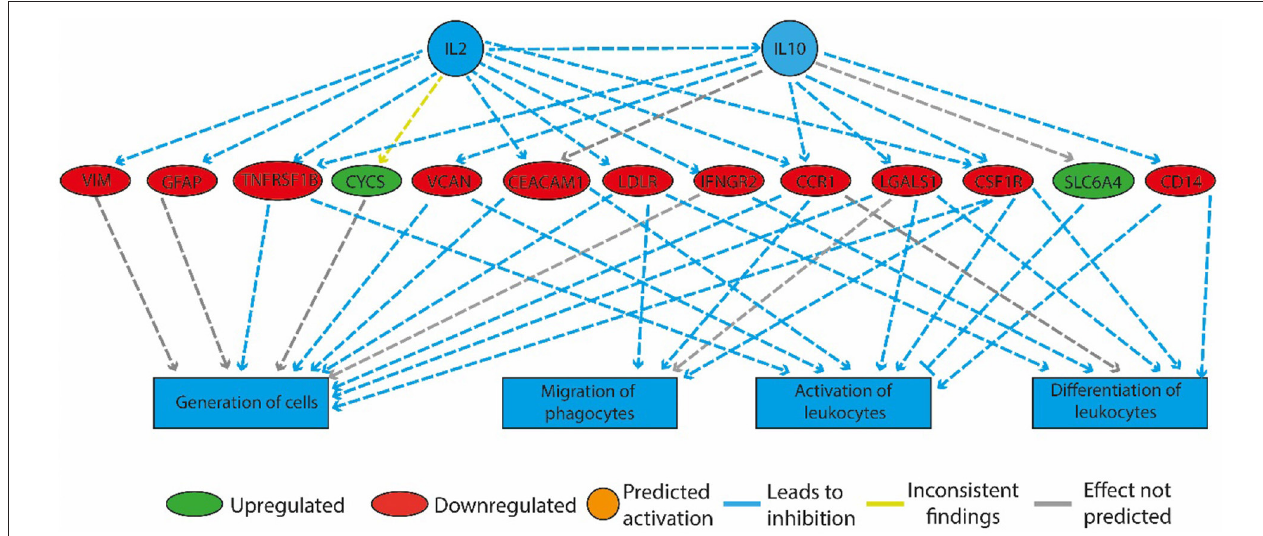
FIGURE 4 | Physical activity in high-fat fed rats downregulated genes involved in inflammation. The regulatory network that is illustrated consists of three tiers. The top tier consists of predicted upstream regulators that might explain the gene expression changes observed in the experiment. IL2 and IL10 are the upstream regulators whose predicted activated state may explain the altered regulation of the middle tier genes. The observed gene expression changes lead to a predicted decrease in “generation of cells,” “migration of phagocytes,” “activation,” and “differentiation of leukocytes” (bottom tier).